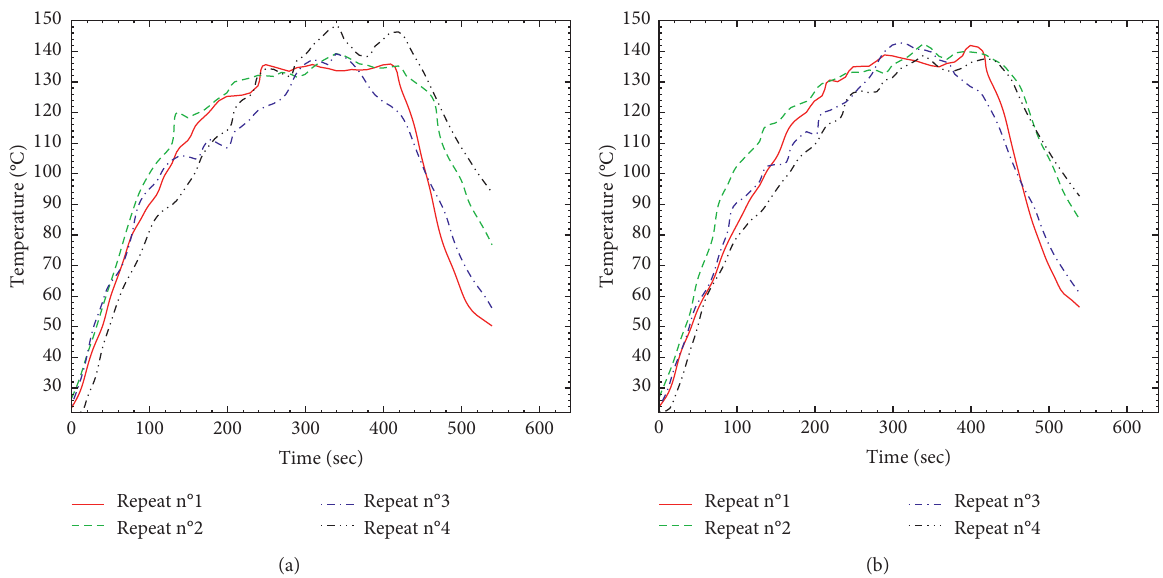
Figure 9: (a) Temperature profiles of TH1 plotted during tests in the PFC configuration. (b) Temperature profiles of TH3 plotted during tests in the PFC configuration.